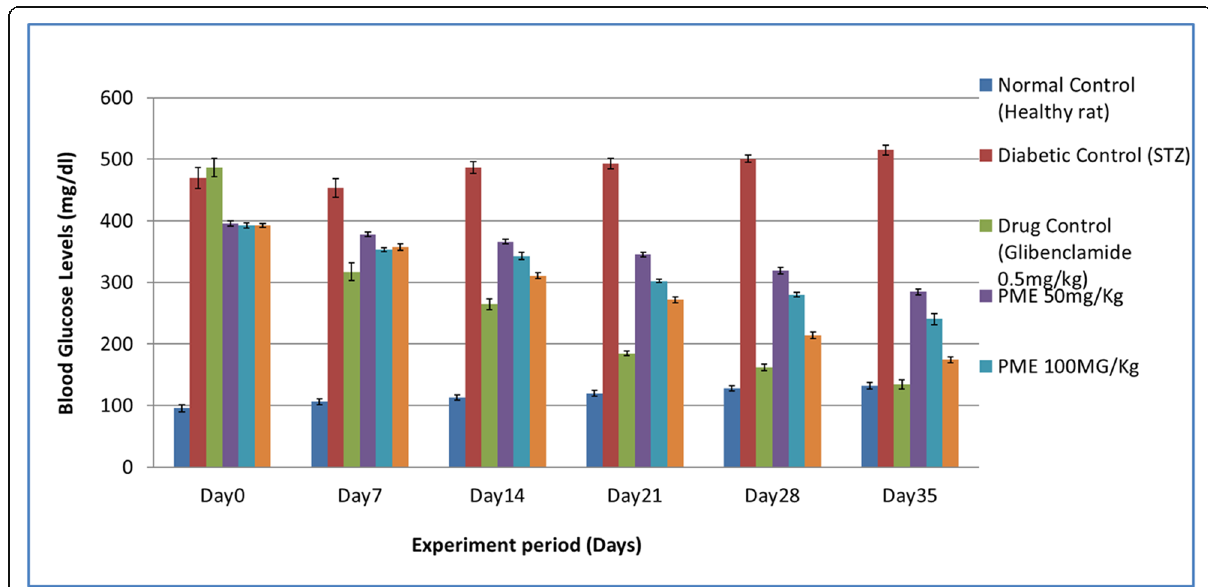
Fig. 4 Fasting plasma glucose levels after repeated oral administration of ethanol extract of EEPM fruits for 35 days (5 weeks) in normal (drinking water), diabetic (untreated), diabetic (glibenclamide), and treatment (50, 100, and 200 mg/kg) rats. Data are expressed as means ± SEM, n = 6 rats per group. p < 0.05; p < 0.01, when compared to starting values